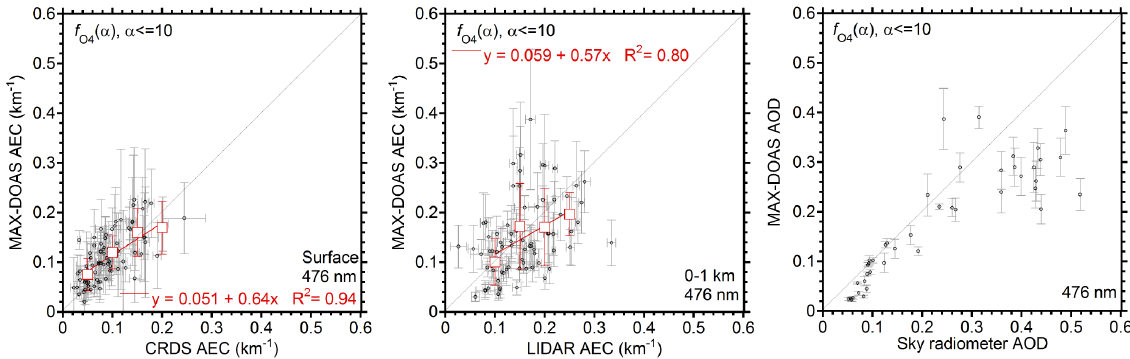
is assumed to be a function of α in the MAX-DOAS retrieval. α used in the retrieval has been limited to Figure 16. Same as Fig. 5, but f O 4 ≤ 10 ◦ .